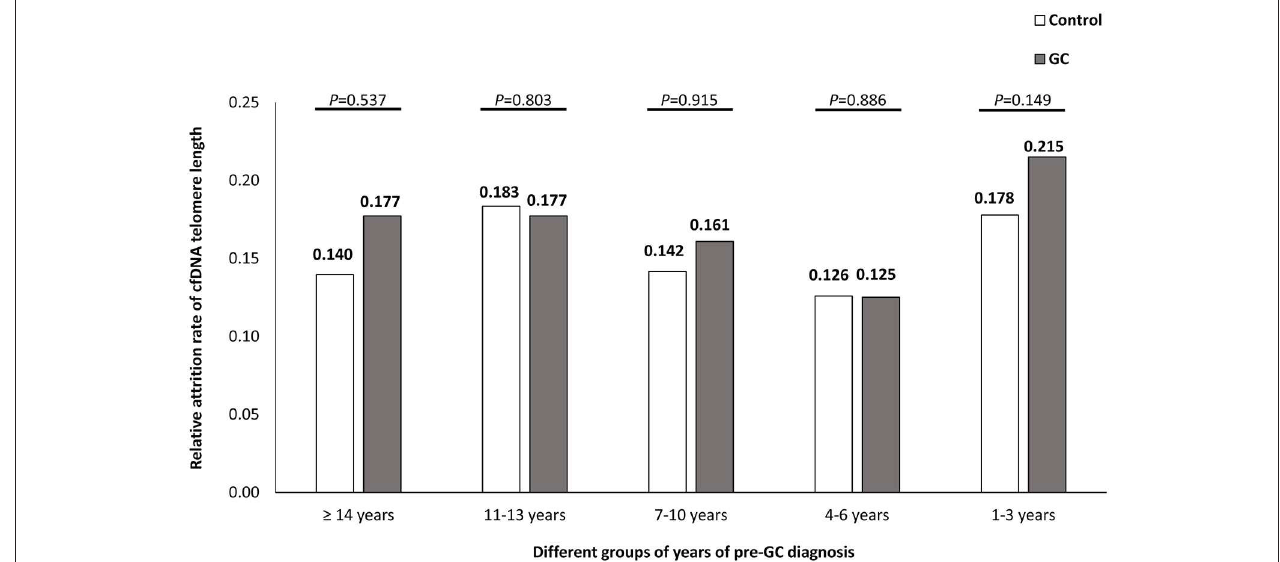
FIGURE 2 | The temporal trends of relative annual telomere attrition rates in GC and control groups. The years before GC-diagnosis of pre-diagnostic samples from GC subjects were classified into five groups as ≥ 14 years, 11–13 years, 7–10 years, 4–6 years, and 1–3 years, respectively. The annual attrition rates between GC and control groups were compared by Wilcoxon rank-sum